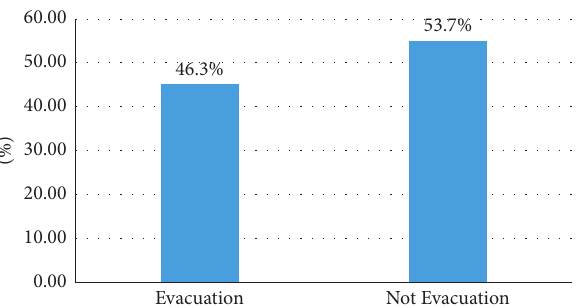
Figure 7: Frequency distribution of action choice in response to